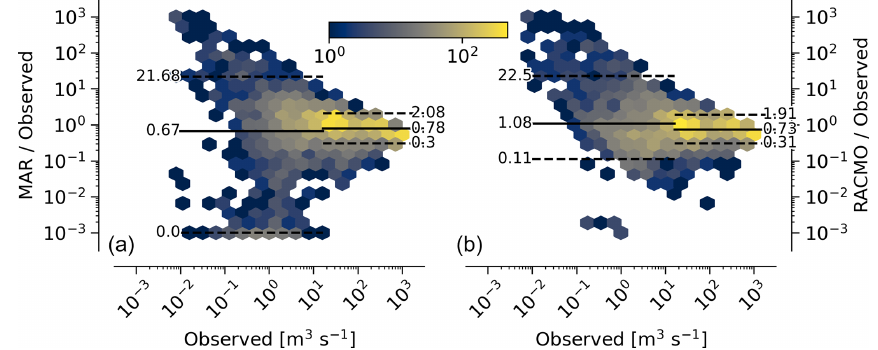
Figure 5. Modified Tukey plot for non-Nuuk observations. Observation vs. ratio of RCM to observations for MAR (a) and RACMO (b) , discussed in Sect. 4.2.1. Number of samples at a location is represented by color. The horizontal solid line shows the mean, dashed lines show the 5% to 95% quantile range, and the horizontal split denotes the bottom one-third and top two-thirds quantiles of observed discharge. The four near-Nuuk GEM basins which have glaciers not included in the RCM domain are excluded.